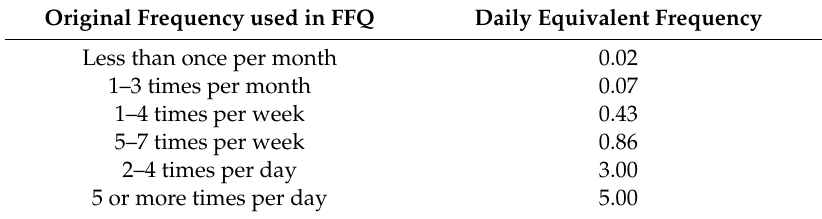
FFQ: Food Frequency